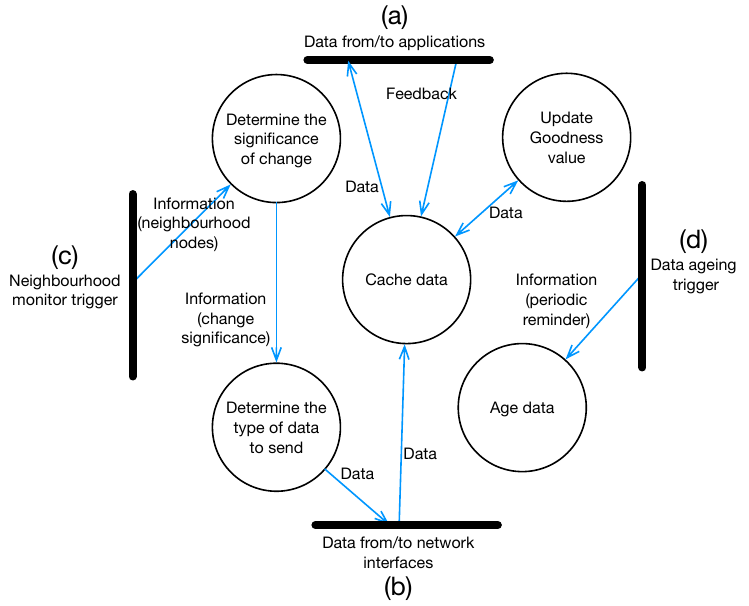
Figure 3. Flow diagram of KEETCHI consisting of a number of software modules, triggers and interactions: ( a , b ) external stimuli ; and ( c , d ) internal stimuli. These stimuli trigger the operation of KEETCHI.